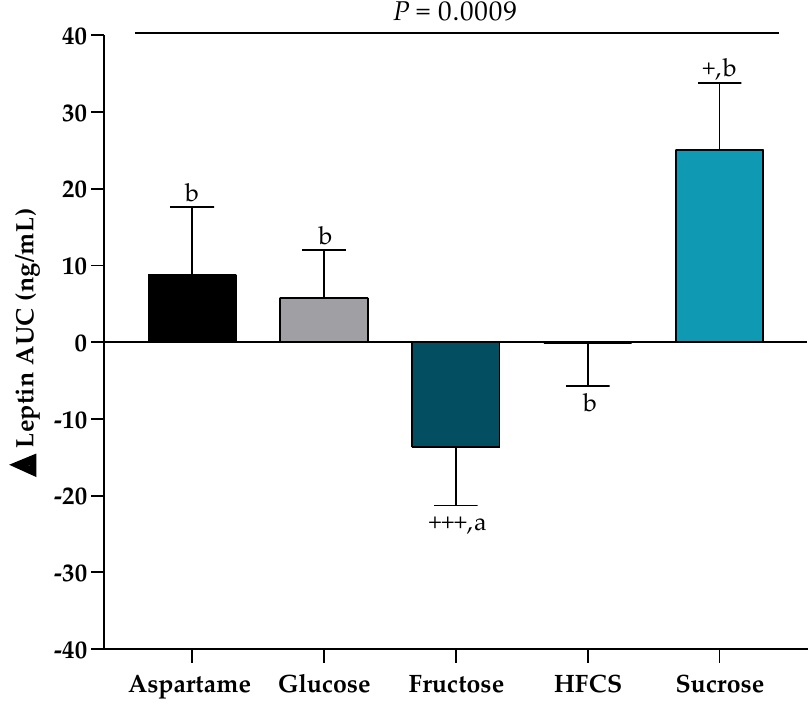
Figure 4. 24-h Leptin AUC: The mean ± SEM of the absolute change (Week 2–Week 0) in leptin AUC in subjects consuming either glucose-, fructose-, high fructose corn syrup (HFCS)-, sucrose-, or aspartame-SB for 2 weeks. p = 0.0009 effect of SB, 2-factor (SB group, sex) analysis of covariance with adjustment for % body fat and outcome at Week 0; + p < 0.05, +++ p < 0.001, LS mean different from zero; a different from b, Tukey’s multiple comparison test.